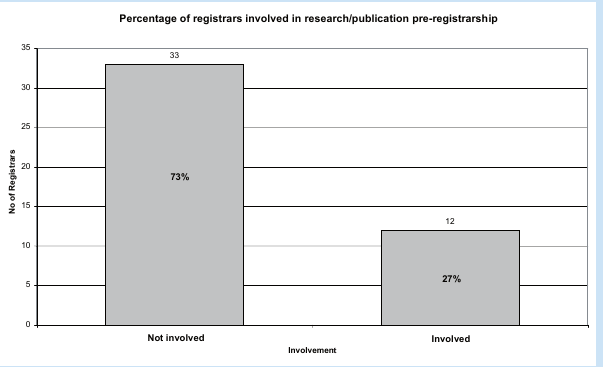
Fig. 4. Percentage of registrars involved in research/publicatioin pre-regis- trarship. Fig.4.Percentageofregistrarsinvolvedinresearch/publicationpre-registrarship.